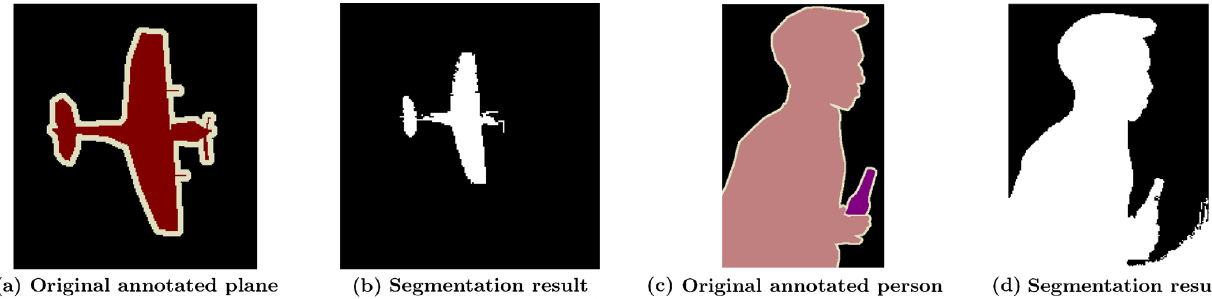
Fig. 10 Annotated and respective segmentation result for plane and person from VOC2012 challenge datasets using proposed method.